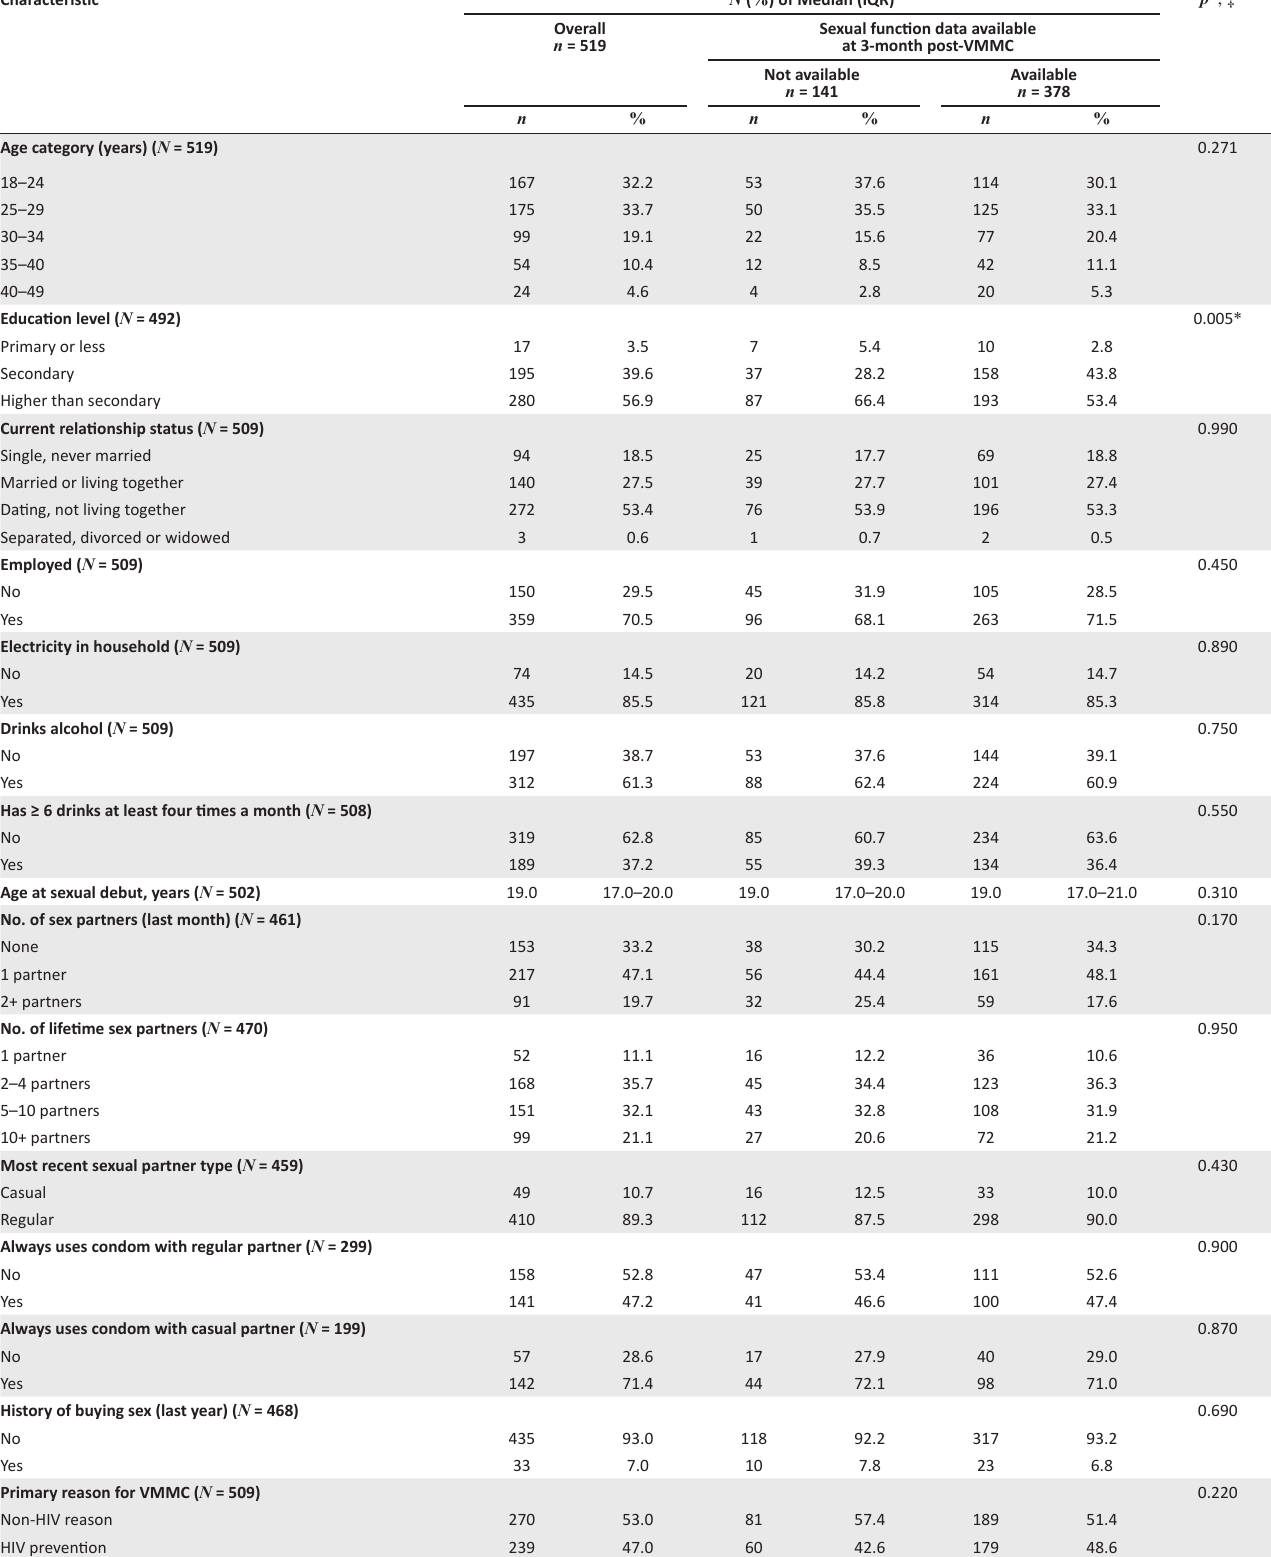
TABLE 1: Baseline characteristics of men who were uninfected by the human immunodeficiency virus who underwent voluntary medical male circumcision, by availability of sexual function data at 3-months after voluntary medical male circumcision.